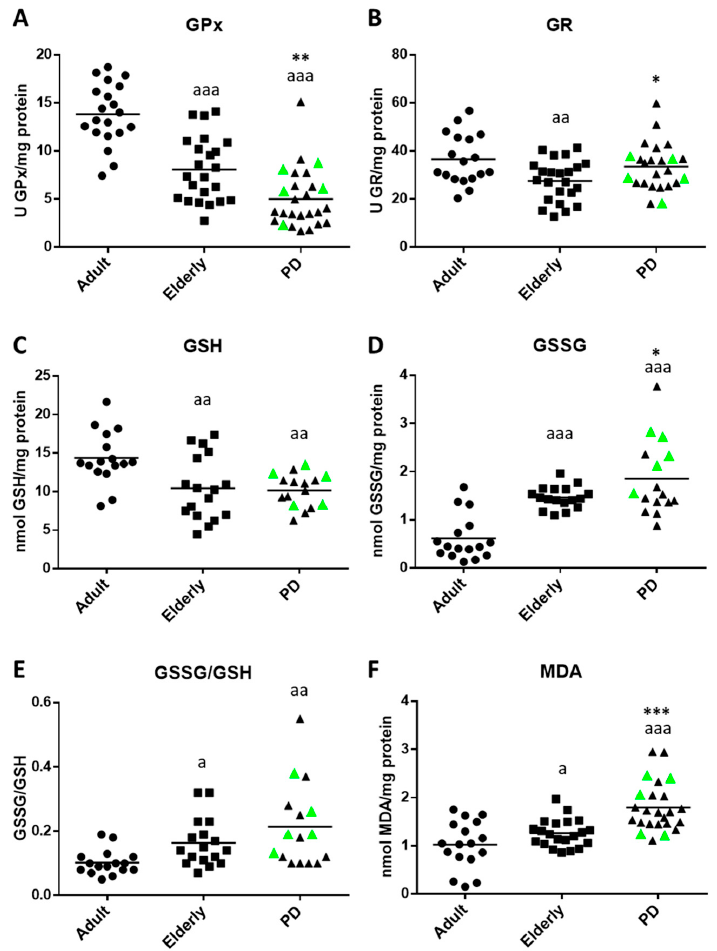
Figure 3. Oxidative stress and lipid peroxidation parameters in whole blood cells, containing both total red blood cells and leukocyte populations, of Parkinson´s Disease (PD) stage 2 patients, as well as of adult and elderly healthy subjects. ( A ) Glutathione peroxidase (GPx) and ( B ) glutathione reductase (GR) activities (U/mg protein); ( C ) intracellular reduced glutathione (GSH) concentrations and ( D ) oxidized glutathione (GSSG) contents (nmol/mg protein); ( E ) GSSG/GSH ratios; and ( F ) intracellular malondialdehyde (MDA) contents (nmol/mg protein). Data are shown as the mean (horizontal bar) of 16–23 values corresponding to the number of subjects analyzed in each group (20 adult, 23 elderly, 26 PD). Each value is the mean of duplicate assays. The green points represent the values in five PD patients treated with levodopa. a: p < 0.05, aa: p < 0.01, and aaa: p < 0.001 with respect to the value in adult subjects; * p < 0.05, ** p < 0.01, and *** p < 0.001 with respect to the value in elderly subjects.